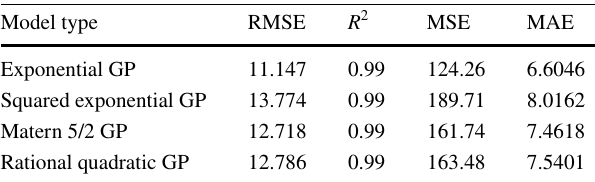
Table 2 Summary of the results of the GP model selection Model type